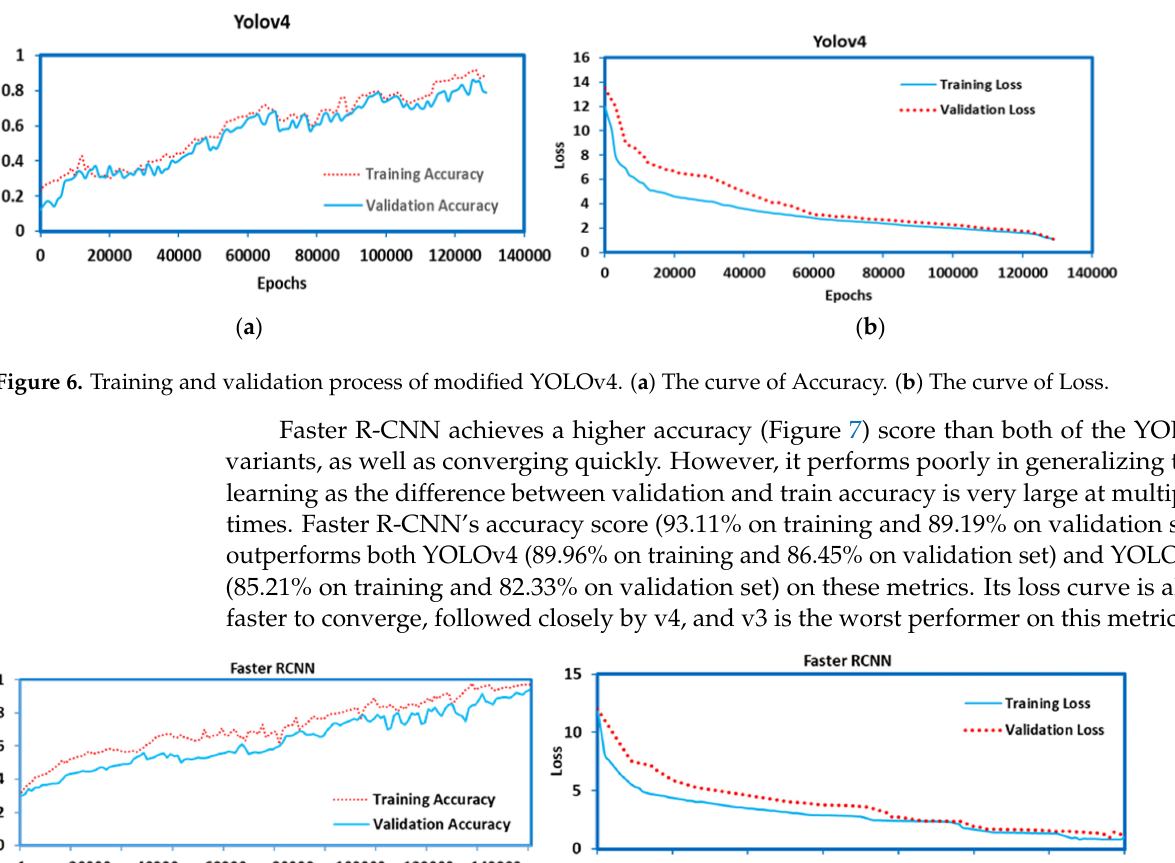
in real-time than v3.